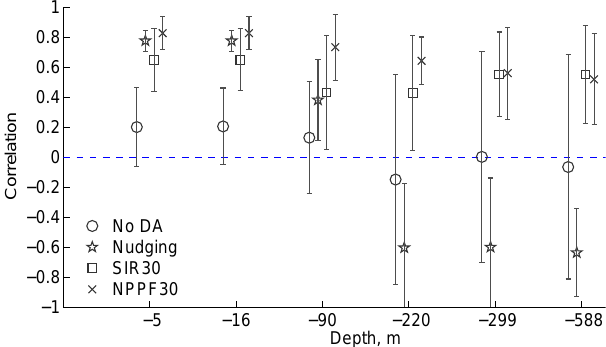
Fig. 4. Assimilation of dense pseudo-observations. Correlations between first PCs of the pseudo-observations and projections of the model simulations onto the corresponding first EOFs of the pseudo-observations for ocean temperature at different depths. EOFs are computed for May–October of six 21-year periods over the area southward of 60 ◦ S . The circle is the mean correlation for simulations without data assimilation; the star is the mean correlation for the model simulations using the nudging; the square is the mean correlation for the model simulations using the sequential importance resampling filter over the polar cap southward of 30 ◦ S ; the cross is the mean correlation for the model simulations using the nudging proposal particle filter over the polar cap southward of 30 ◦ S . Error bars correspond to one standard deviation.